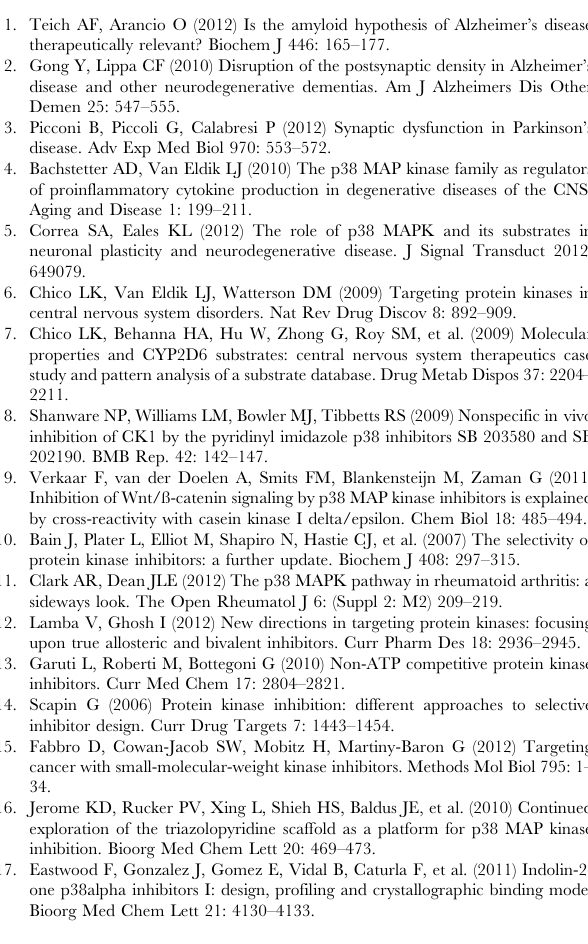
Figure S1 Design strategy for structure-driven refinement of p38 a MAPK inhibitor hit. (DOC) Figure S2 Kinetic analysis of MW01-11-108SRM inhibition of p38 a MAPK. (DOC) Figure S3 Kinetic analysis of MW01-10-181SRM inhibition of p38 a MAPK. (DOC) Scheme S1 Synthetic scheme for other p38 a MAPK inhibitors. The synthetic scheme and experimental details for compounds in addition to MW108 and MW181 are given. Table S1 MW01-11-108SRM kinome screen. Table S2 MW01-10-181SRM kinome